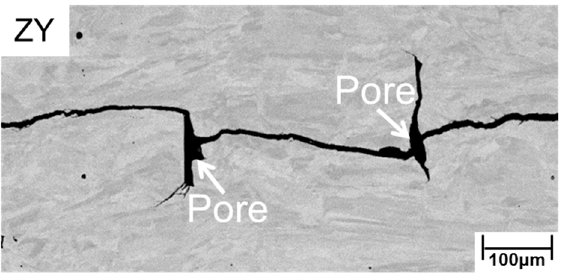
Figure 14. Crack branching at oblonged pores (aspect ratio range of 1.3 to 2.8) in the additively manufactured 316L in the ZY specimen.